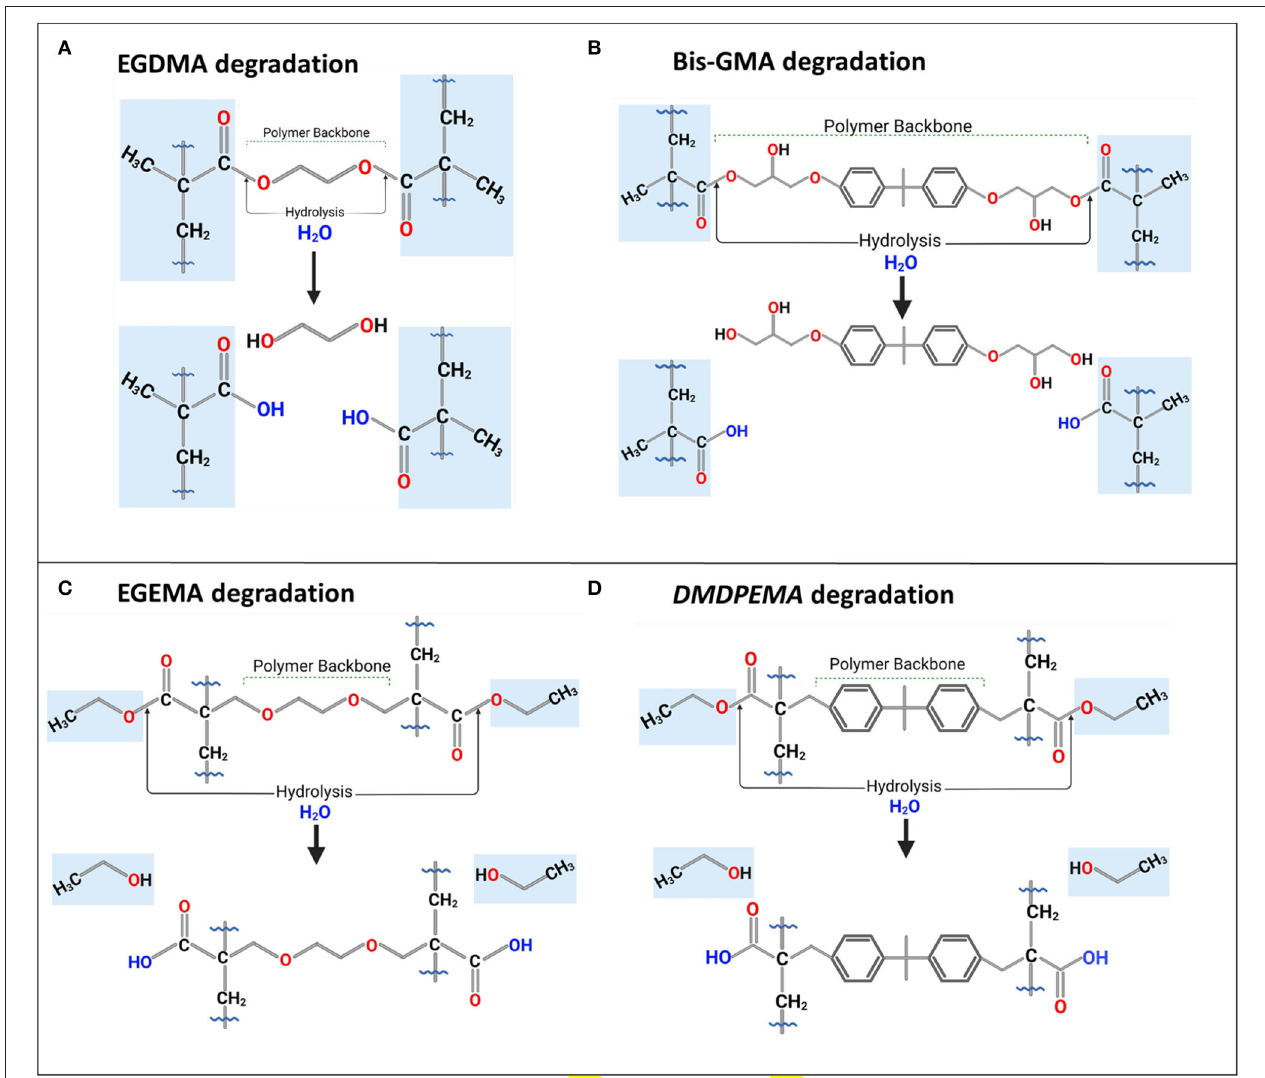
FIGURE 4 | Degradation or bio-degradation of (A) EGDMA and (B) Bis-GMA with their backbone as by-products; their analogs, (C) EGEMA, and (D) DMDPEMA with ethanol as by-product and backbone preserved during hydrolysis. Figures in (A,C) based on figures in ( 28, 30, 31).